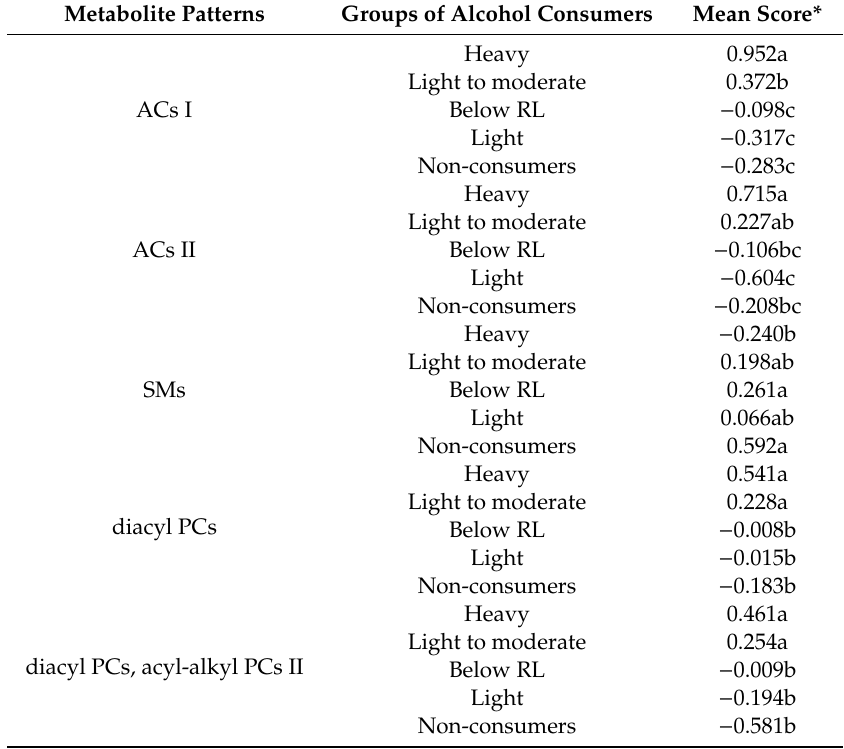
Table 2. Mean score di ff erences of male participants at the time of recruitment (1994–1998) in EPIC-Potsdam in six metabolite patterns. Metabolite